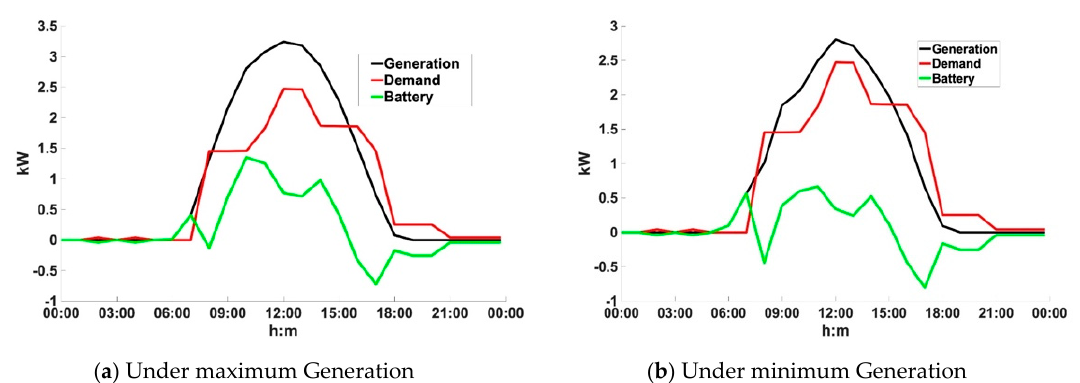
Figure 14. Power flow for generation, demand and battery under Standard efficiency in the case of maximum and minimum generation: ( a ) under maximum generation; ( b ) under minimum generation.